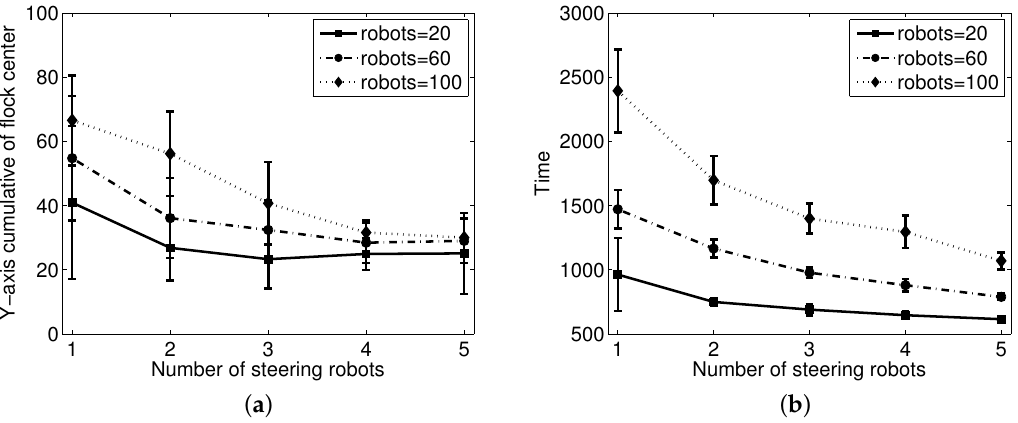
Figure 7. Comparison of varying numbers of steering and sheep robots: ( a ) cumulative score of the y-position deviation of the center of the sheep flock from the y-axis and ( b ) time needed to reach the goal